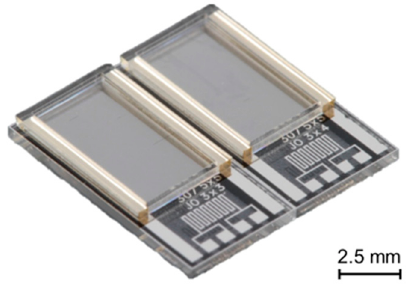
Figure 1. Photograph of the differential sensor set-up of two IDE arrays, consisting of two independent sensing areas of 20 mm 2